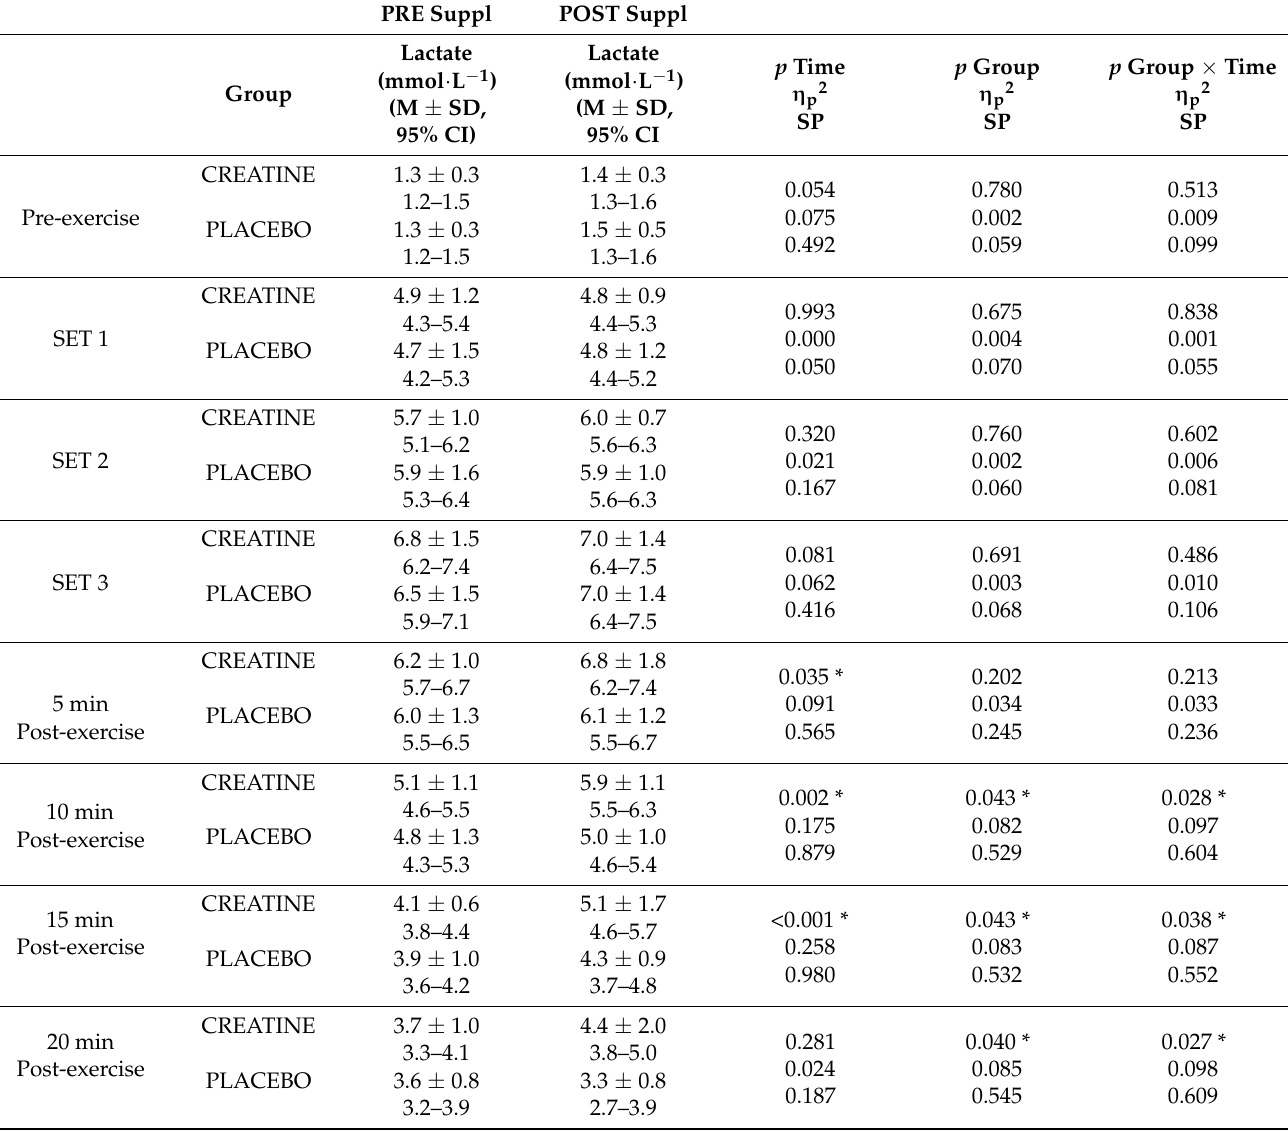
Table 3. Data related to the repetitions of the bench press exercise protocol with a load of 70% MVP obtained in the 1RM test of each individual. PRE Suppl POST